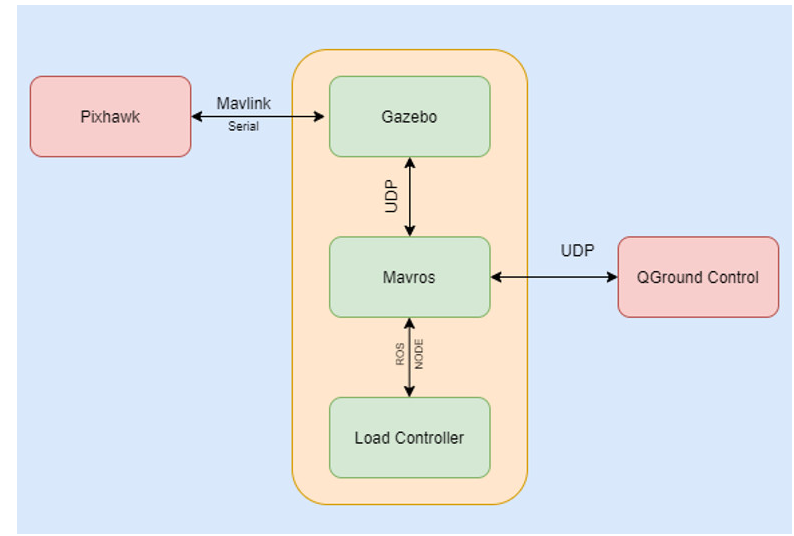
Figure 4 . Hardware-in-the-loop (HIL) communication diagram